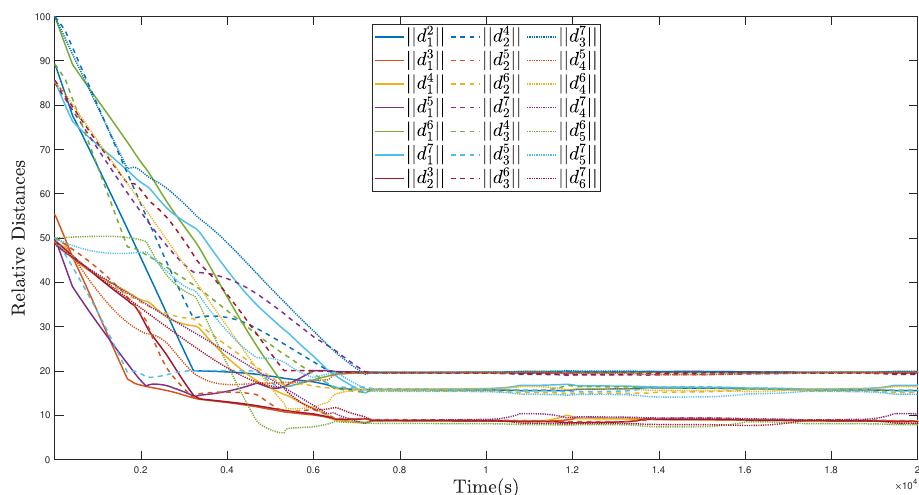
Figure 14. Relative distances of the MSAs system in the moving target coverage process.